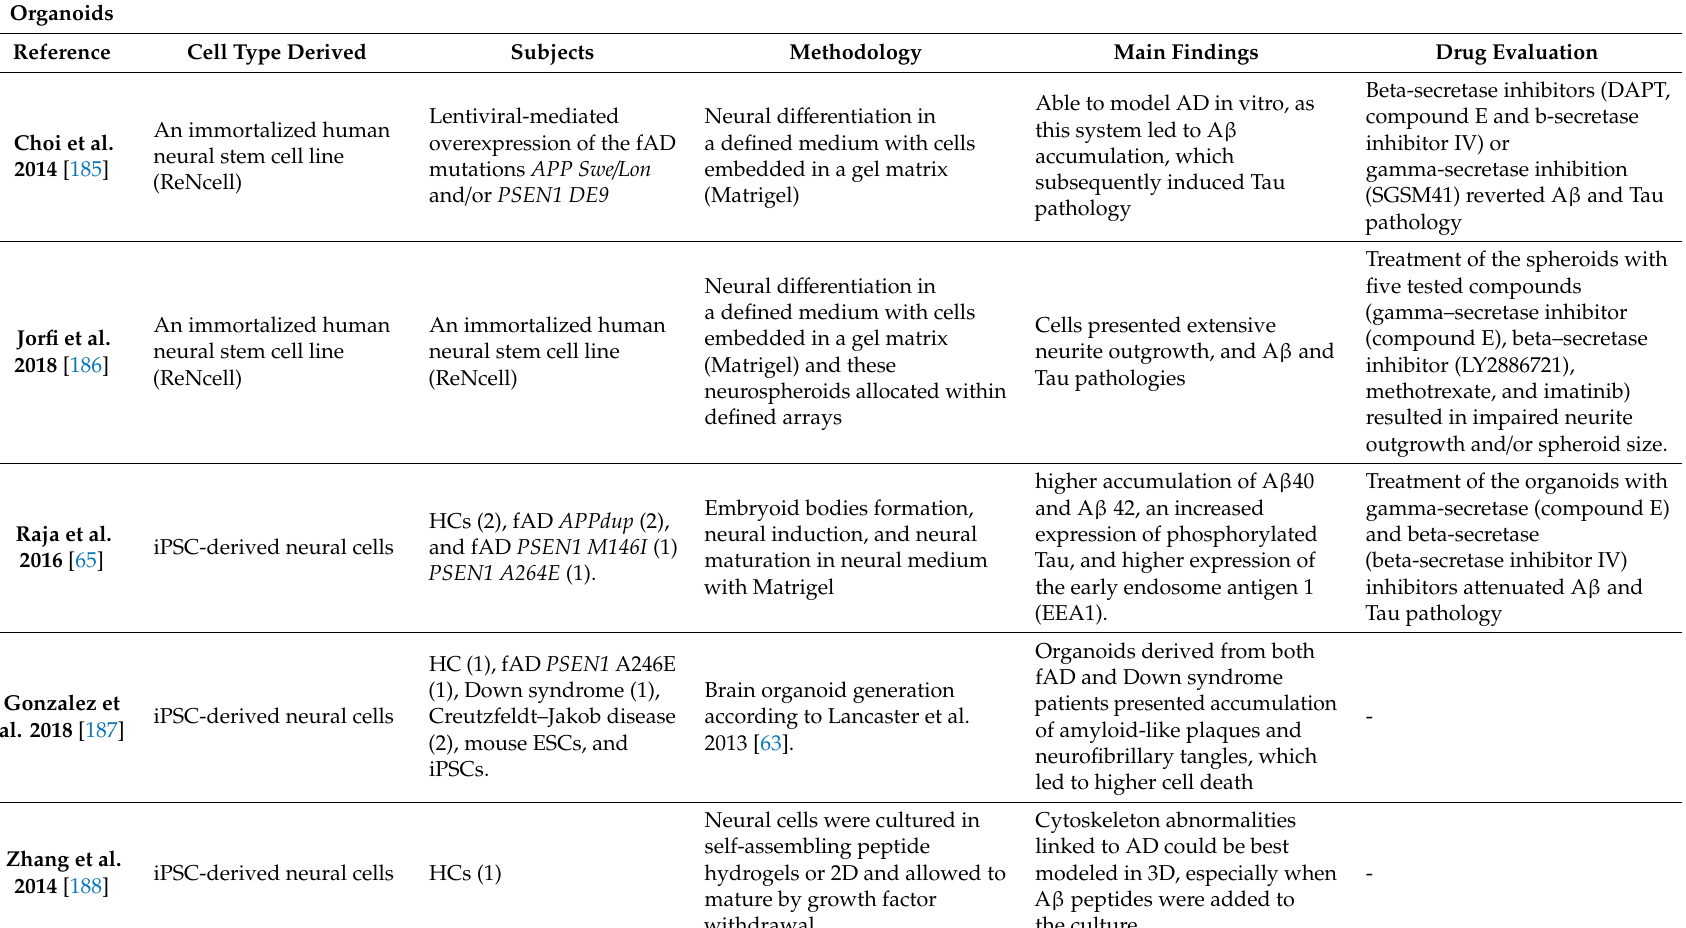
Table 4. Summary of the findings of the main studies describing the generation of hPSC-derived brain organoids and neural 3D cultures from patients with Alzheimer´s disease.